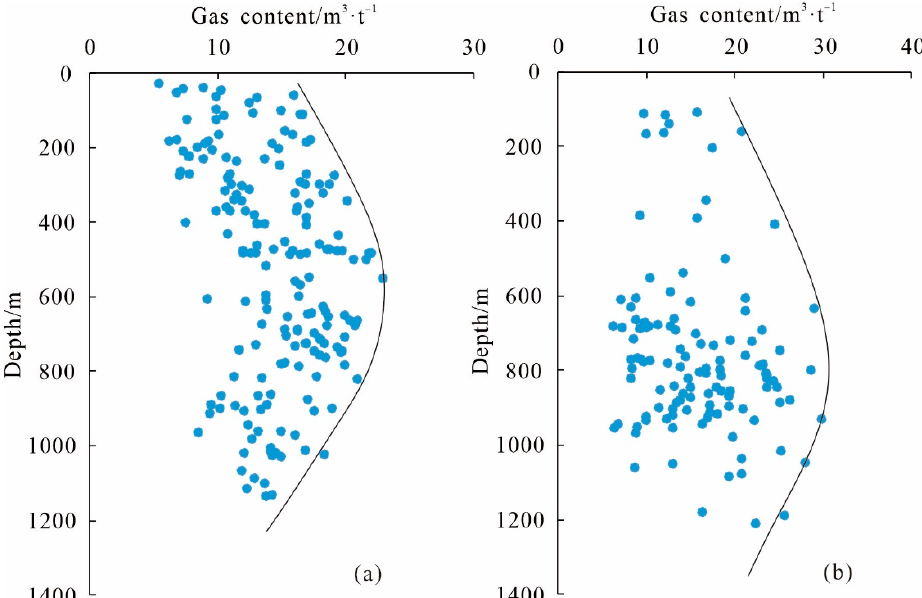
Figure 6. Relationship between gas content obtained from log interpretation and depth of the middle and high rank coals. ( a ) Dahebian Block; ( b ) Dafang Block.